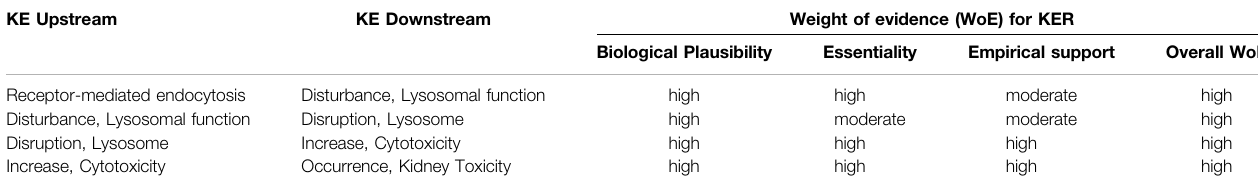
TABLE 5 | Weight-of-evidence analysis of KERs in the adverse outcome pathway of receptor-mediated endocytosis and lysosomal overload leading to kidney toxicity. KE Upstream KE